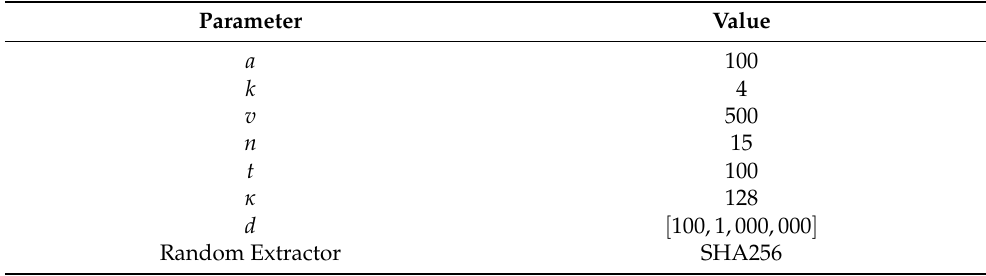
Table 2. Implementation parameters of our